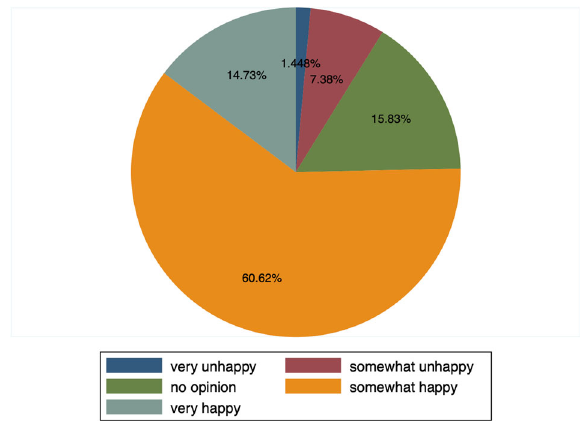
Fig. 3 Happiness distribution for rural residents. In terms of the question of “ whether life is happy ” , 14.73% of respondents felt “ very happy ” , 60.62% reported “ somewhat happy ” , and 15.83% of respondents claimed “ no opinion ” . In comparison, only 7.38% and 1.448% reported “ somewhat unhappy ” and “ very unhappy ” , respectively. The distribution of happiness shows that approximately 75% of the respondents reported a clear sense of happiness, indicating that rural residents ’ happiness is generally